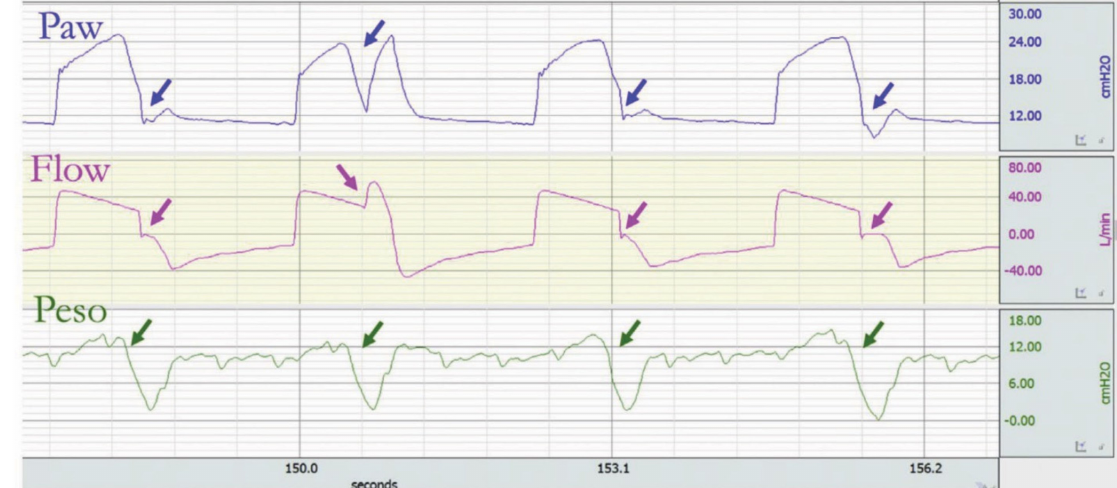
Figure 6. Reverse triggering in volume assist–control with decelerating flow. Each insufflation is triggered by the ventilator; in the middle (breath 2) or at the end of the inspiration phase (breaths 1, 3, and 4), a negative deflection of the esophageal pressure (Peso) happens (green arrow), leading to a negative deflection of the airway pressure (Paw) (blue arrow) and increasing flow during the ventilator insufflation phase or reducing it during the ventilator expiratory phase (pink arrows). Reprinted with permission from [17].